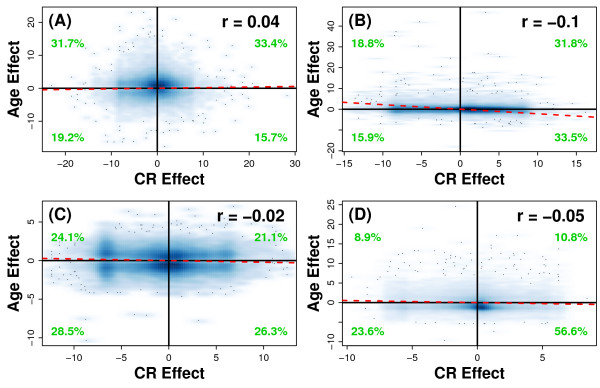
Relationship between caloric restriction and aging in liver, heart, muscle and the central nervous system. The association between CR and aging was evaluated for the (A) liver, (B) heart, (C) muscle and (D) central nervous system (hippocampus + cortex). The CR effect is positive for genes up regulated by CR and negative for genes down regulated by CR (see Figure 7 legend). Likewise, the age effect is positive for genes up regulated with age and negative for genes down regulated with age (see Figure 7 legend). The abundance of genes in relation to the CR and age effect is reflected by the color intensity, with deep blue colors corresponding to regions with the largest number of genes. The dashed red line is based upon a least-squares regression fit that quantifies the overall relationship between the CR and aging effects. In each panel, the estimated Pearson correlation is shown in the upper-right, and the percentage values (green font) indicate the fraction of genes that belong to each quadrant. The effects of CR and aging were computed in each organ system based upon p-values generated by combining results from at least 3 independent experiments. In liver, CR and aging effects are based upon 9 and 7 experiments, respectively. In heart, CR and aging effects are based upon 5 and 10 experiments, respectively. For muscle and central nervous system, CR and aging effects are each based upon 3 -6 experiments. For each organ, distinct sets of data were used to estimate the CR and aging effects, such that CR and aging effects are a priori independent.